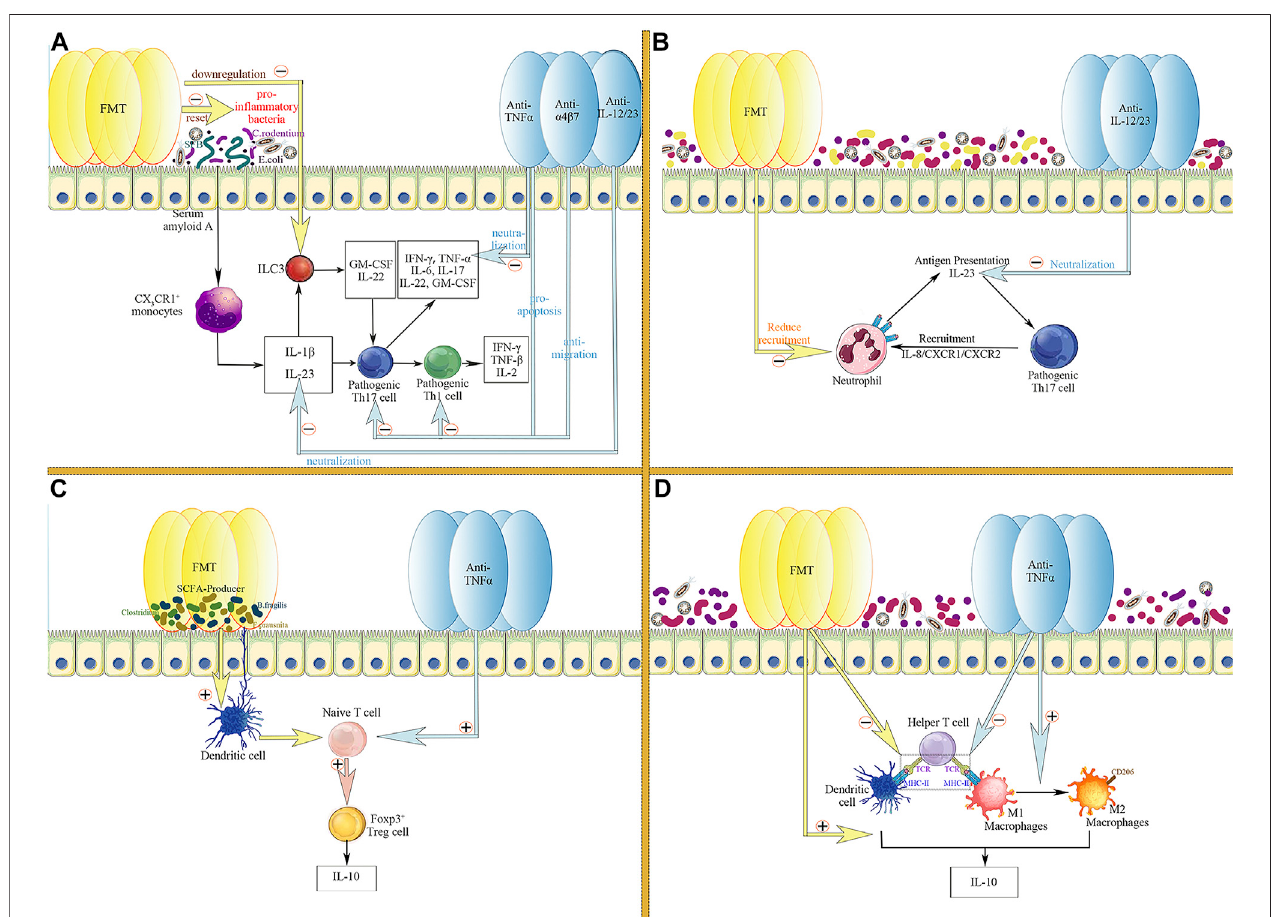
FIGURE 3 | Common targets of FMT and biologic agents in the regulation of intestinal in fl ammatory responses. (A) FMT and biologics co-inhibit the activation and proliferation of pathogenic Th17 and Th1 cells; (B) FMT and biologics co-target the crosstalk between neutrophils and pathogenic Th17 cells; (C) FMT and biologics jointlypromotetheproliferationofFoxp3 + Tregcellsandtheformationoftheanti-in fl ammatorycytokineIL-10; (D) FMTandbiologicsdownregulatethefunctionofhelper T cells through inhibiting antigen presentation by APCs, including macrophages and dendritic cells, thereby suppressing the expansion of the in fl ammatory response; Meanwhile, FMT and biologics jointly promote the production of the anti-in fl ammatory cytokine IL-10 by APC.